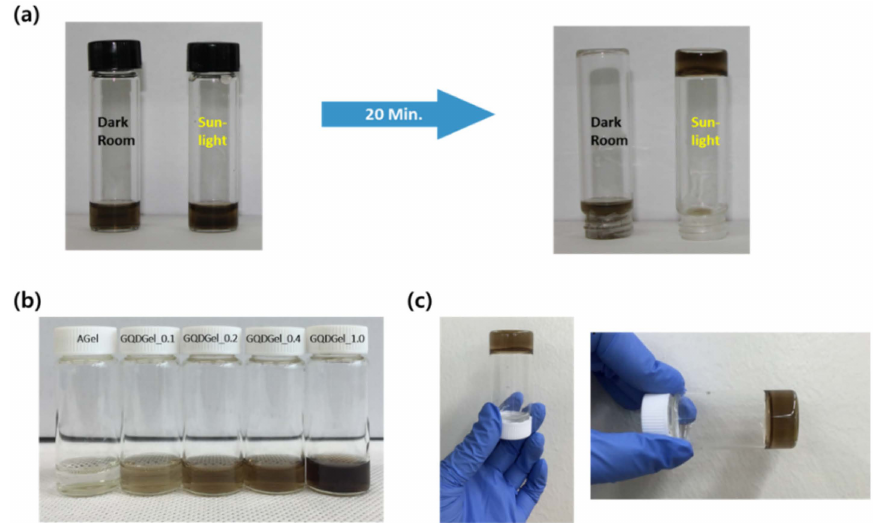
Figure 2. Photographs of the fabricated hydrogel samples. ( a ) Photographs of the GQD-incorporated gel samples before/after incubation in a dark room and under sunlight. ( b ) Photographs of the concentration-dependent gelation solutions. The numerical values on the labels (0.1, 0.2, 0.4, and 1) indicate the amount of GQD solution in mL included in the 3 mL of gelation solution. These values correspond to 0.0013, 0.0027, 0.0054, and 0.012 wt %, respectively. AGel, or APS-Gel, indicates the hydrogel formed by using ammonium persulfates as photoinitiator instead of GQDs. ( c ) Photographs of GQDGel_0.2 showing the successful gelation.